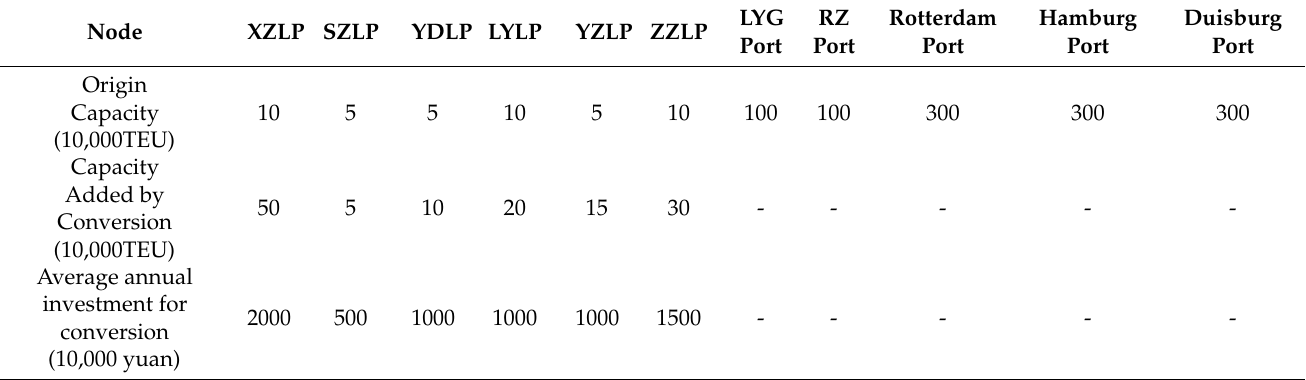
Table 3. Average annual investment for conversion and capacity before/after conversion.